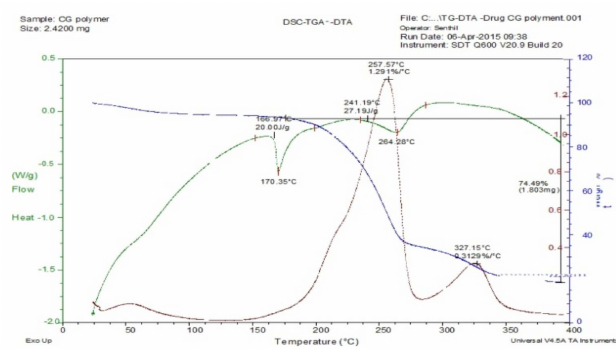
Figure 2. DSC, TGA, DTA of paracetamol + CGM.